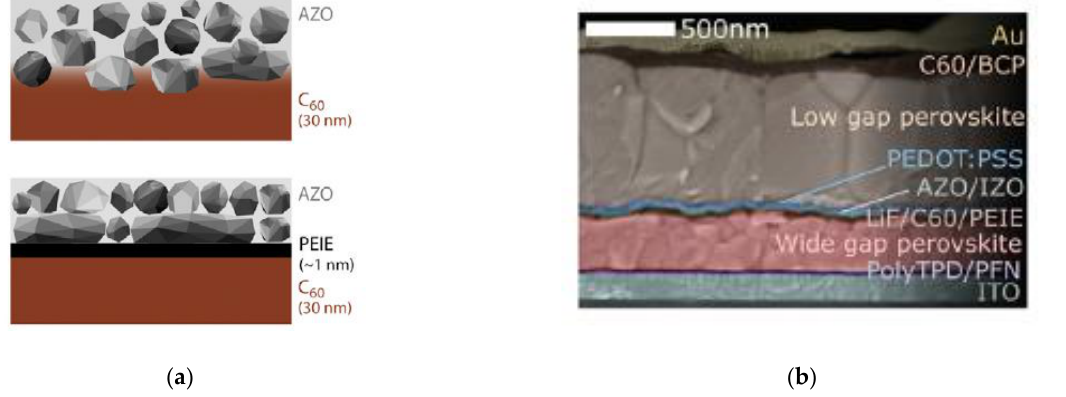
Figure 5. Incorporation of ALD AZO as recombination layer in all-perovskite tandem solar cell: ( a ) Schematic of AZO without and with poly(ethylenimine) ethoxylated (PEIE) nucleation layer; ( b ) Cross-sectional SEM of solar cell stack; Reproduced from [63], with permission from Elsevier, 2019.